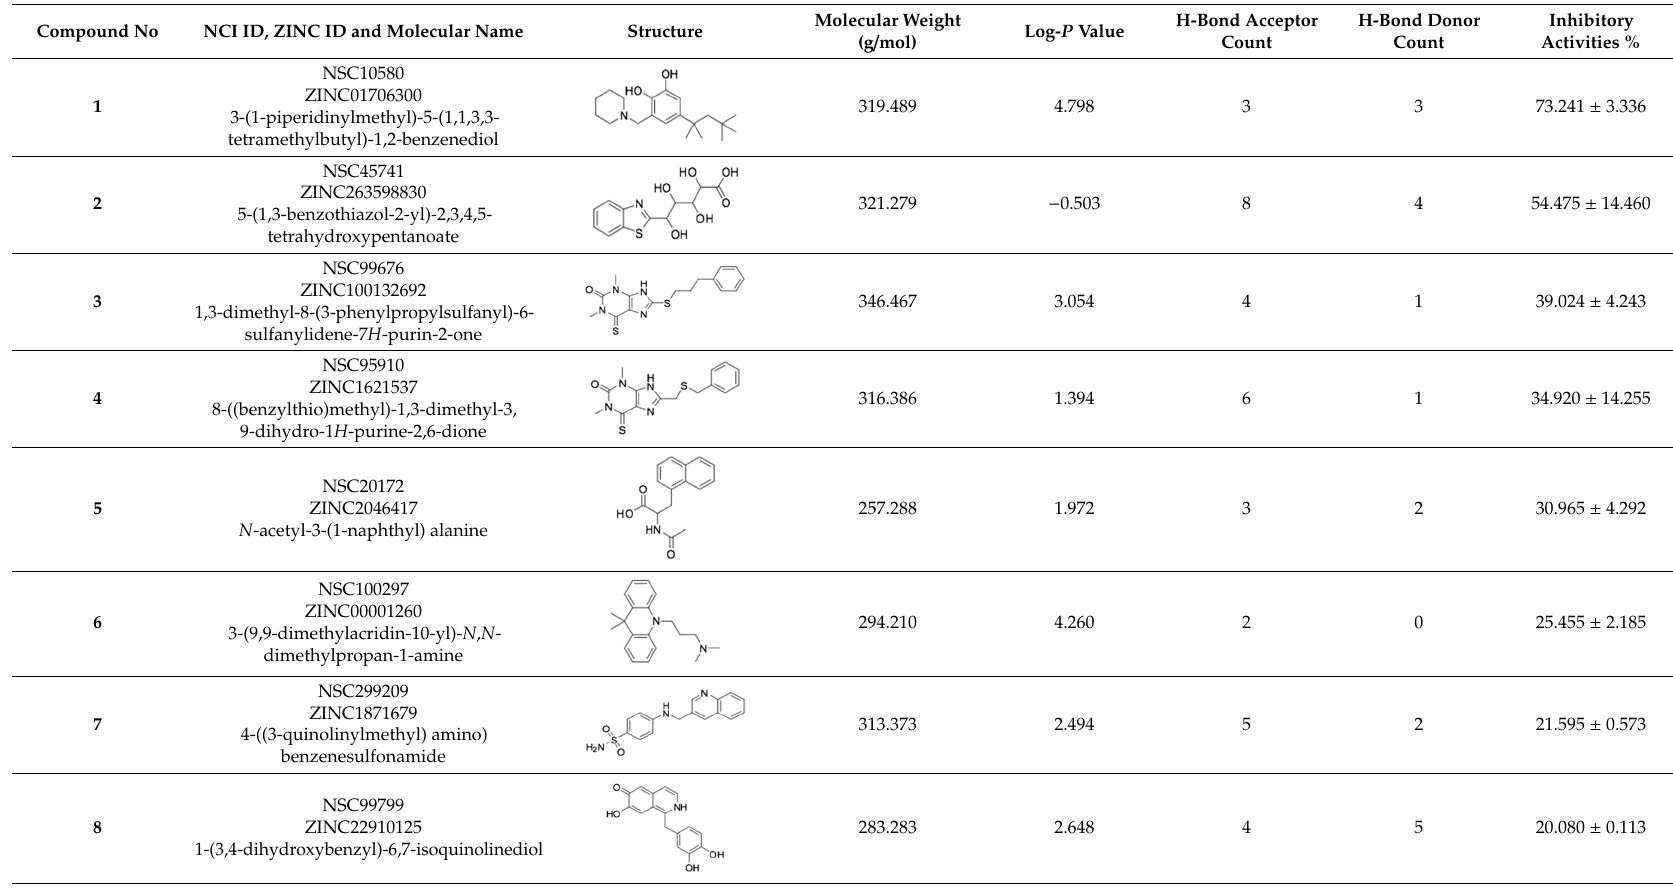
Table 1. Initial compounds identified by structure-based virtual screening and antiviral evaluation. Compounds presented by National Cancer Institute (NCI) ID, ZINC ID, molecular name, 2D chemical structure, chemical properties, and experimental inhibitory activities. Inhibitory activities at 20 μ M were evaluated by in vitro ZIKV infection assay.